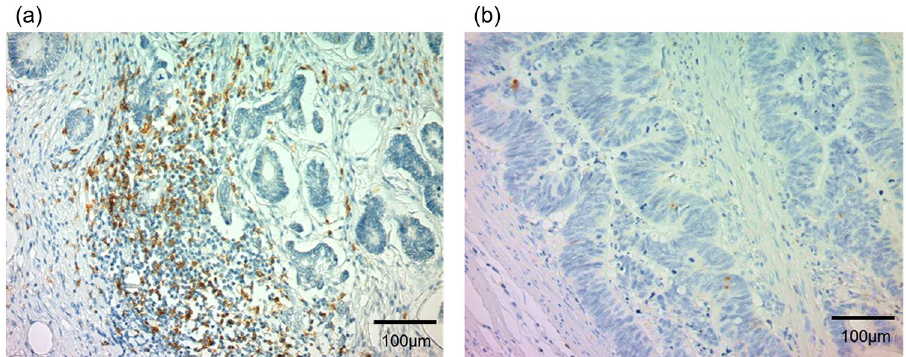
Figure 2. Immunohistochemistry for CD8 expression in colitic cancer and sporadic colorectal cancer. ( a ) High levels of tumoural CD8 cytotoxic T lymphocytes (CTLs) in a representative colitic cancer tissue. ( b ) Low levels of tumoural CD8 CTLs in a representative sporadic colorectal cancer (SCRC) tissue.